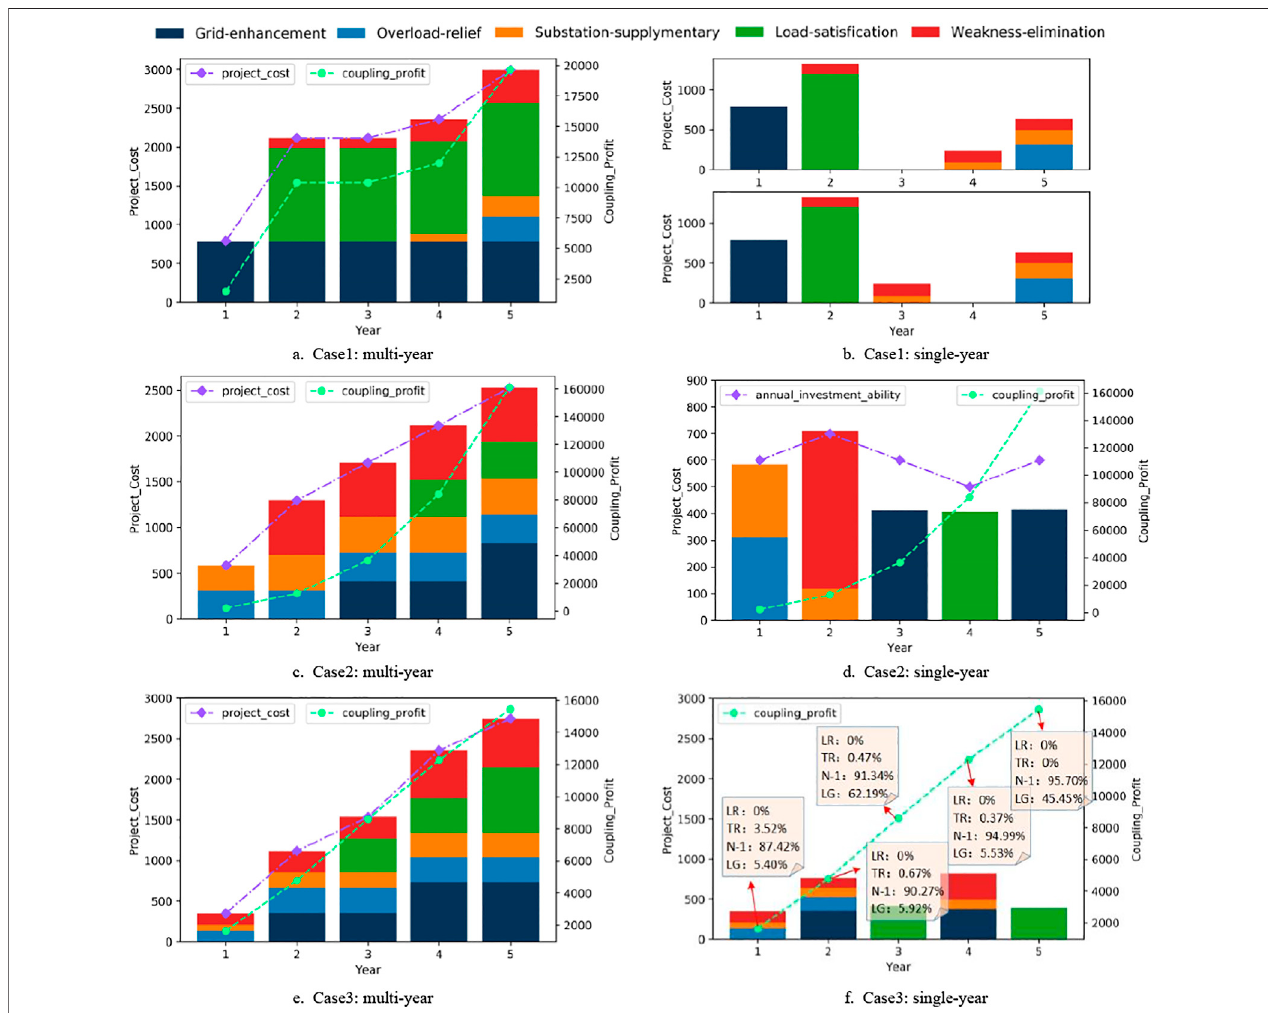
FIGURE 5 | Optimal portfolio scheme under different